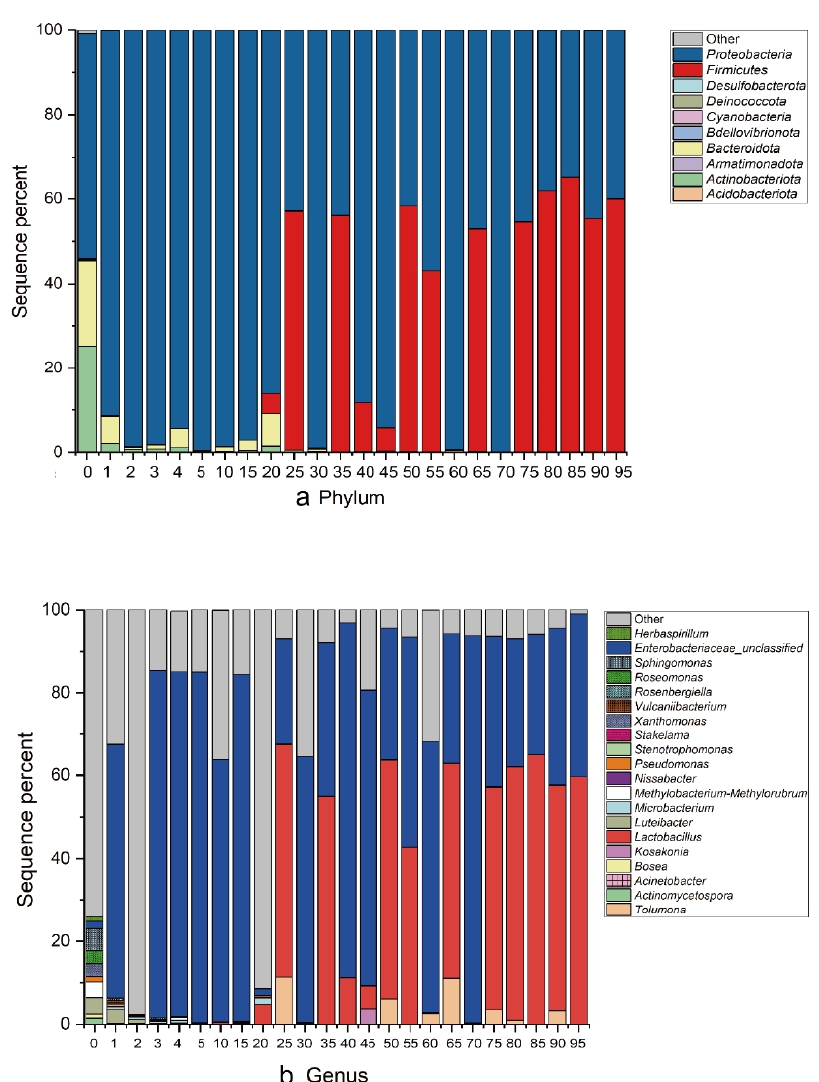
Figure 5. Changes in the bacterial community structure during different fermentation times. The relative abundance of bacteria at the ( a ) phylum and ( b ) genus levels are shown. Each bar represents the relative abundance of each sample. Each color represents a specific phylum or genus.